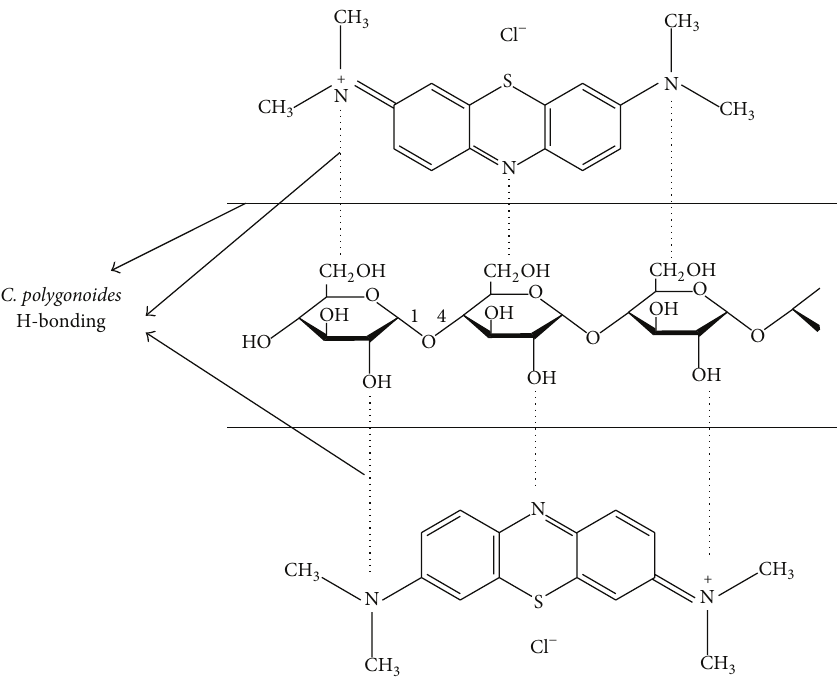
Figure 10: Mechanism of adsorption of MB molecules on